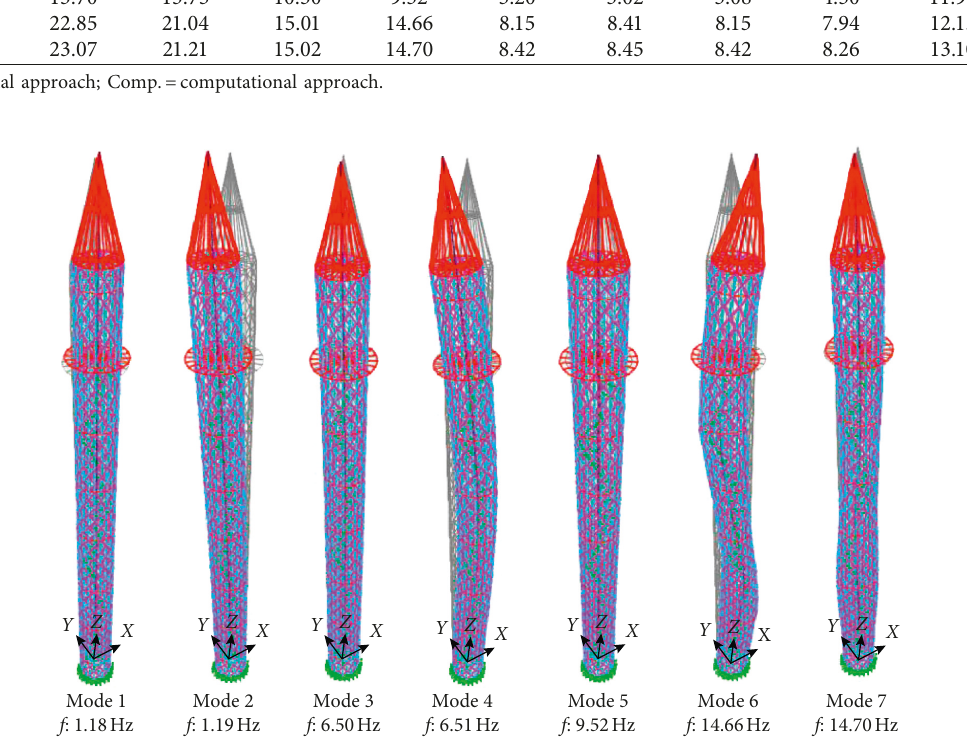
Figure 7: The first seven modes and natural frequencies of the G¨ull¨uk Mosque minaret. Table 8: The mass participation factors of the studied